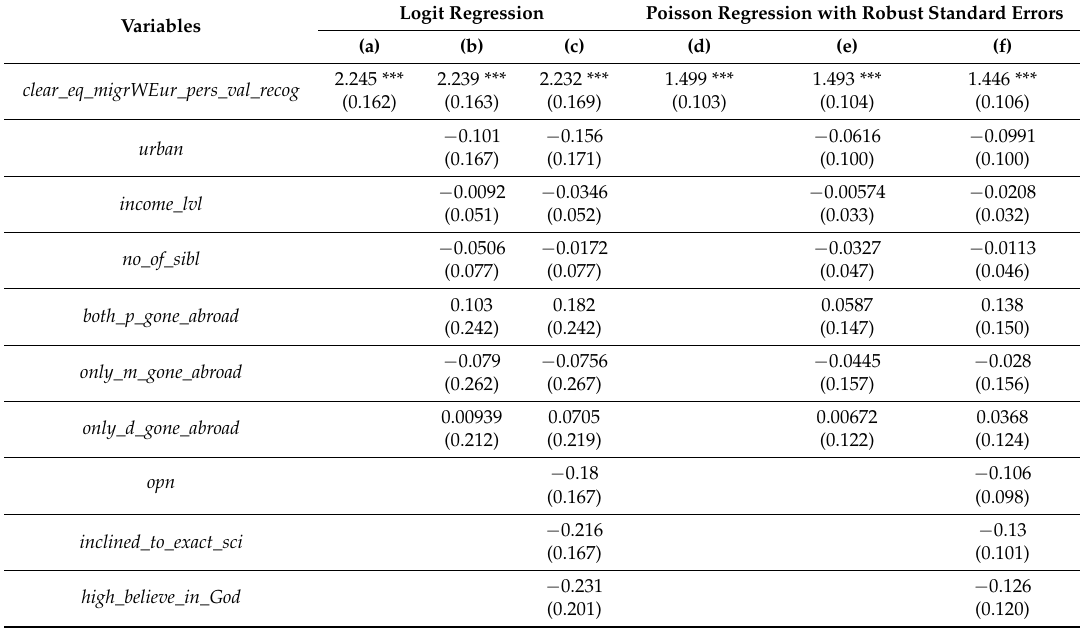
Figure 2. The core (top influence) of the general model as result of using data mining tools: neural networks-based algorithm in Microsoft Excel DM and DMX queries in Microsoft SSAS. Table 2. Raw coefficients (Logit vs. Poisson) of the model based on responses from FEAA, UAIC (Iasi).